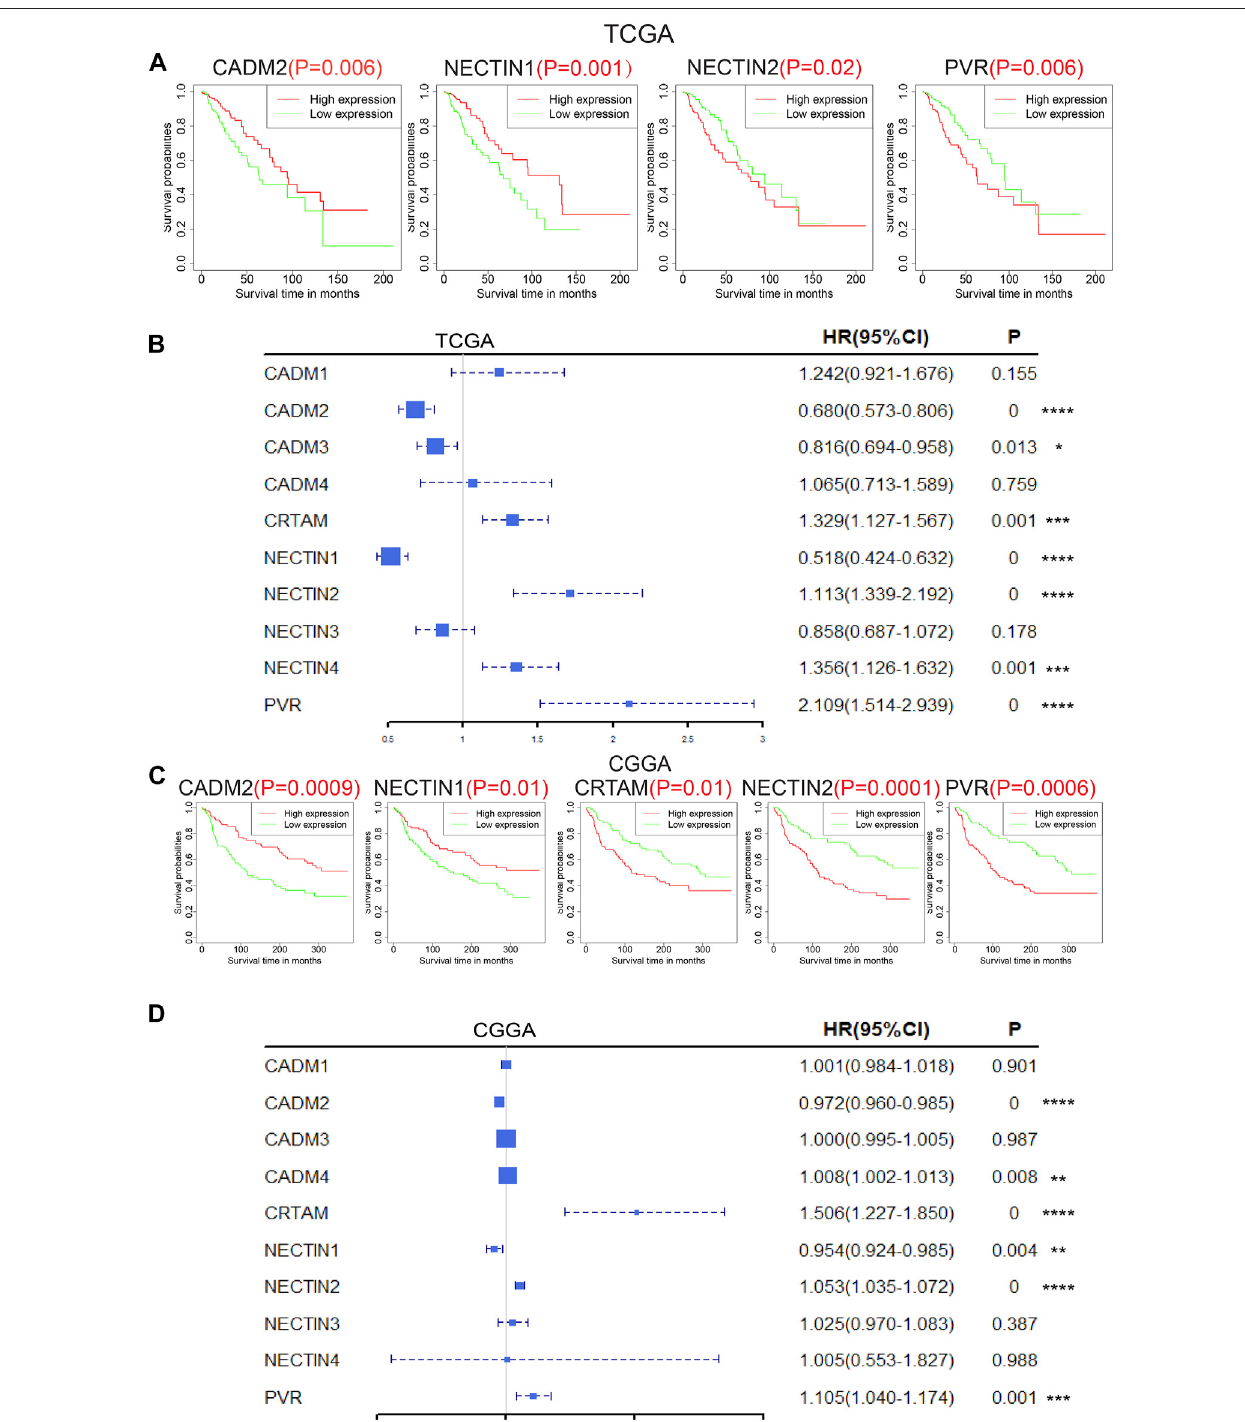
FIGURE 3 | Prognostic value of nectin family members and necls in LGG patients. Survival plot of nectin family members and necls with p < 0.05 in TCGA (A) and CGGA (C) . Forest plot on overall survival of nectin family members and necls with p < 0.05 in TCGA (B) and CGGA (D) .